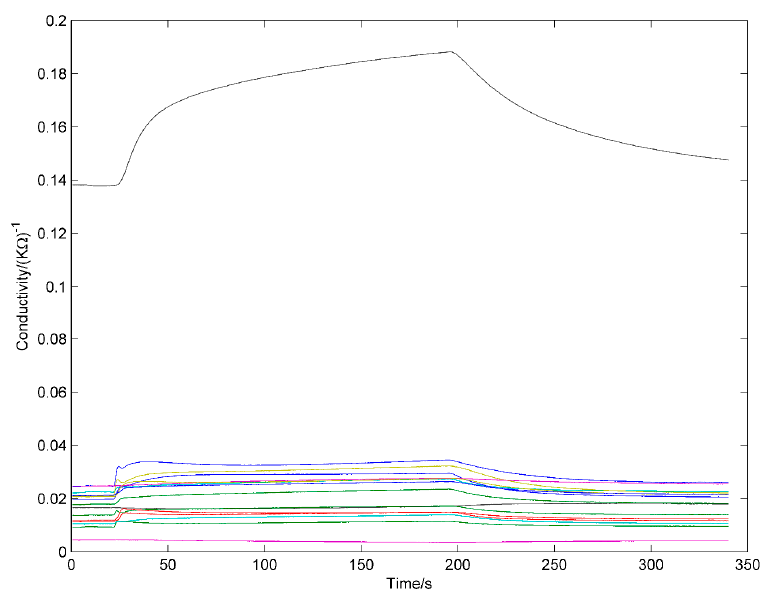
Figure 1. Typical responses of 16 sensors to ginseng samples.